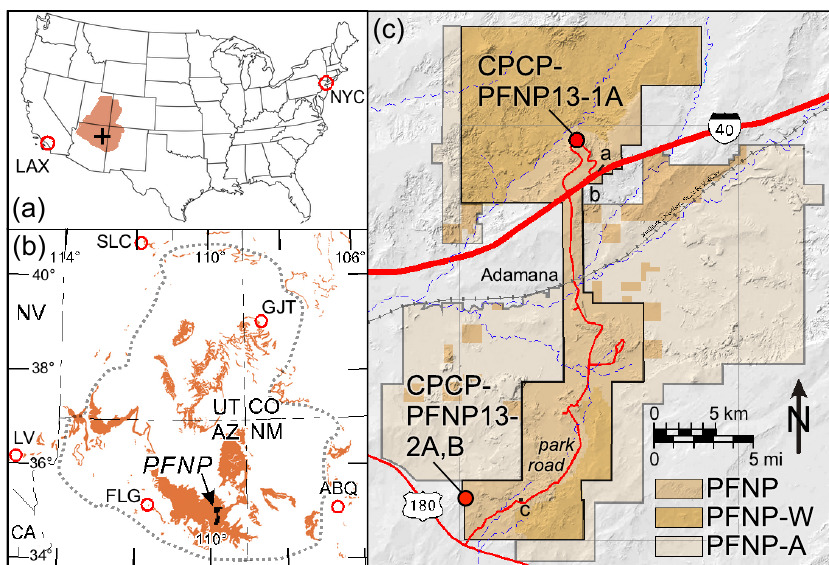
Figure 2. Location of CPCP cores. (a) Location of the Colorado Plateau (red-brown area) in the United States with the cross marking the location of the coring sites in Petrified Forest National Park: LAX, Los Angeles, California; NYC, New York City, New York, which is just to the east and south of the location of the Newark-Hartford APTS (NBCP cores and outcrops). (b) outline of the Colorado Plateau (dotted line) and Triassic outcrop area (red brown) showing the location of Petrified Forest National Park (PFNP): ABQ, Albuquerque, New Mexico (NM); FLG, Flagstaff, Arizona (AZ); GJT, Grand Junction, Colorado (CO); LV, Las Vegas, Nevada (NV); SLC, Salt Lake City, Utah (UT); CA, California. (c) Map of PFNP with location of the coring sites: PFNP, Petrified Forest National Park; PFNP-A, Private or State Trust land; PFNP-W, Petrified Forest National Park, Wilderness area; a, park headquarters; b, park entrance off I-40; c, Rainbow Forest Museum; PFNP-CPCP13-1A, core site at Chinde Point; PFNP-CPCP13-2A, 2B, core site at “West Bone